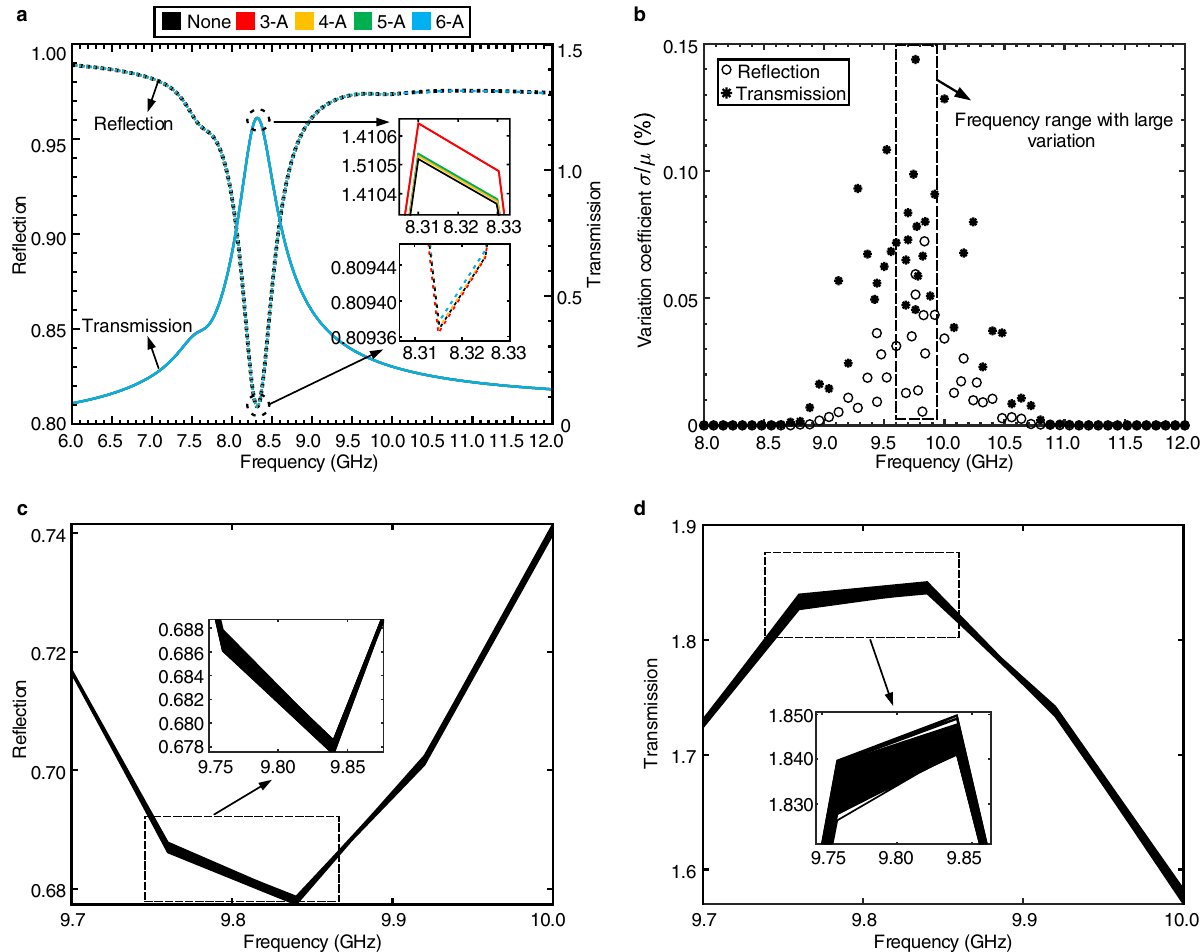
Figure 4. Demonstration of the robustness of the edge state. ( a ) The reflection and transmission spectra of the nontrivial chain when different sub-units are short-connected to the ground. The top/bottom inset shows the zoomed-in view of the transmission/reflection spectra of the circle region that covers the neighbor of the edge state frequency. The tiny variations of the reflection and transmission spectra across different short- connected positions indicate that the presence of defects almost does not affect the behavior of the chain. ( b ) The variation coefficients obtained from 500 rounds MC simulation for each frequency point in a sweeping range of 8.0–12.0 GHz that covers the edge state frequency. The asterisk and the circle indicate the reflection and transmission, respectively. The rectangular box here shows the frequency range where the variation coefficients are significantly larger than that of other frequency ranges. ( c , d ) The reflection and transmission spectra of 500 rounds of MC simulation in the frequency range highlighted by the rectangular box in ( b ). These spectra almost do not differ from each other, indicating the ignorable effect from the random device variations resulted by the practical fabrication